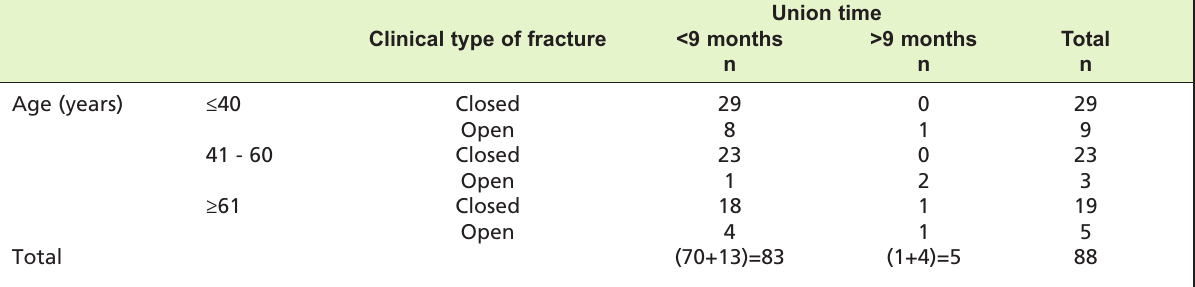
Association between age, clinical type of the fracture and union Table II: